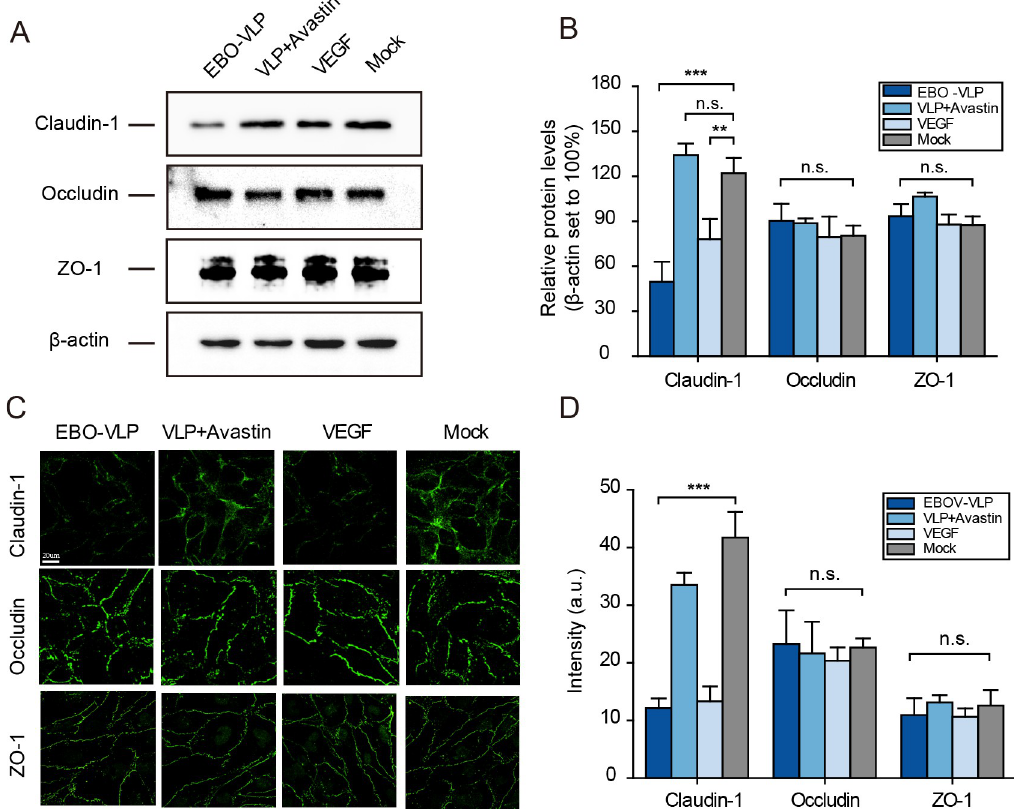
Fig 5. EBO-VLPs downregulate the tight junction protein Claudin-1 in the iBRB. (A) Western blot analysis of claudin-1, occludin and ZO-1 expression in HREC at 48 h in the tri-culture iBRB model. Representative images of three independent experiments are shown. (B) Relative protein levels of claudin-1, occludin and ZO-1 were normalized to β -actin. The results are presented as the means ± standard deviation of three independent experiments. (C) Immunofluorescence images of claudin-1, occludin and ZO-1 expression in HRECs at 48 h post EBO-VLP treatment in the tri-culture iBRB model. Representative images of three independent experiments are shown. (D) Quantification of the fluorescence intensity of claudin-1, occludin and ZO-1 after EBO-VLP administration. The regions for fluorescence intensity analysis were determined in four independent experiments. �� p < 0.01, ��� p < 0.001.